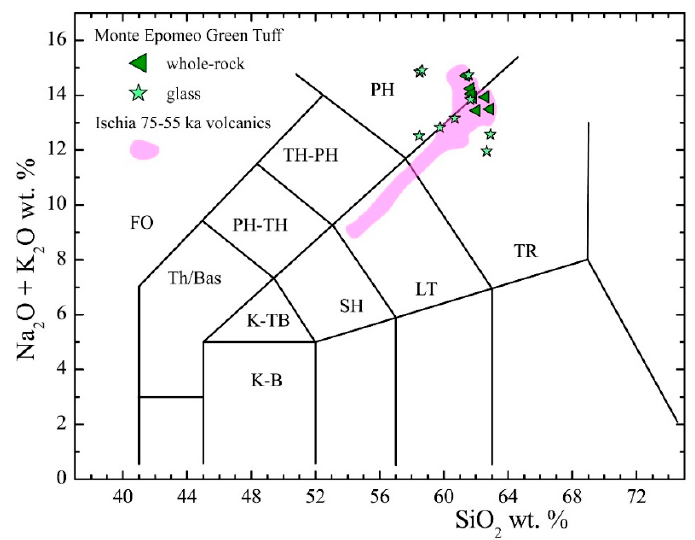
Figure 7. Total alkali vs. silica classification diagram (TAS; [57]) showing the composition of apparently fresh glass analysed in MEGT volcanic rocks (this work; data from Supplementary Table S1), compared with whole rock data on MEGT and 75–55 ka Ischia volcanic rocks from the literature [11,15]. All analyses were plotted after normalisation to 100% on a water-free basis, according to recommendation by I.U.G.S. [57]. K-B = potassic basalt; K-TB = potassic trachybasalt; SH = shoshonite; LT = latite; TR = trachyte (these rock names are relative to a potassic alkaline series); TH/Bas = tephrite/basanite; PH-TH = phonotephrite; TH-PH = tephriphonolite; PH = phonolite.